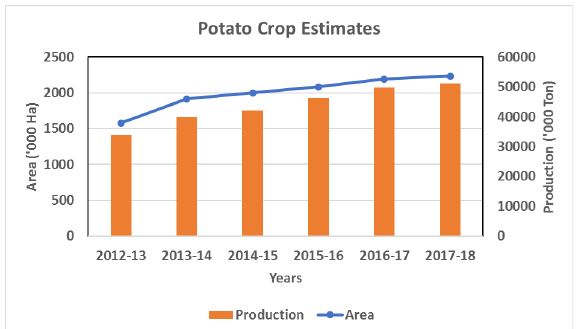
Figure 4: Trend of national level estimated Potato area, and